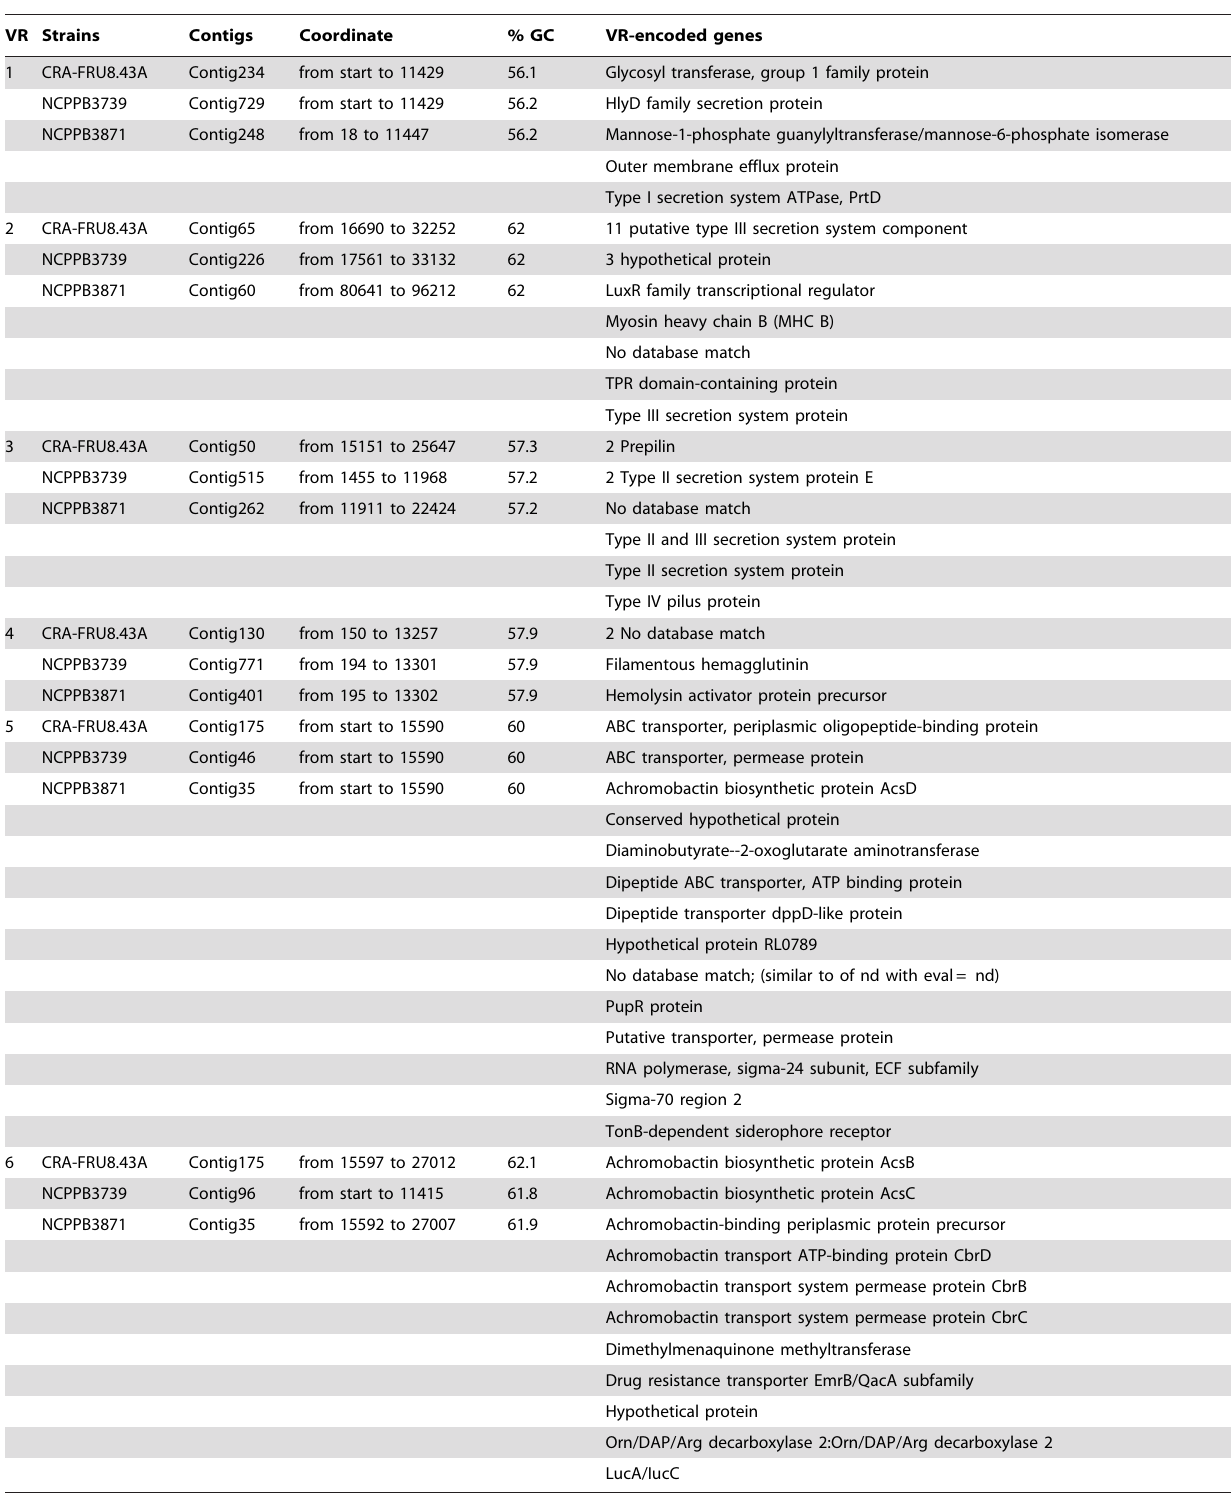
Table 2. Variable regions (VR) found in the draft genomes of J- Psa (NCPPB 3739), I- Psa (NCPPB 3871) and I2- Psa (CRA-FRU 8.43) compared with the complete genome of Pto